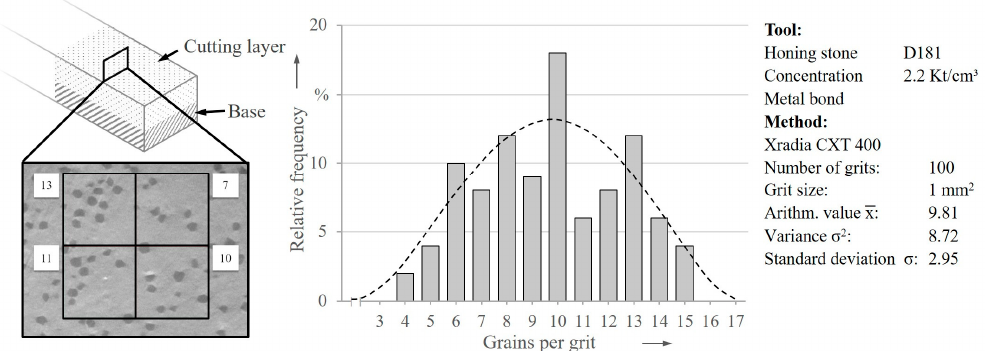
Figure 10. Distribution quality examined by computed tomography.